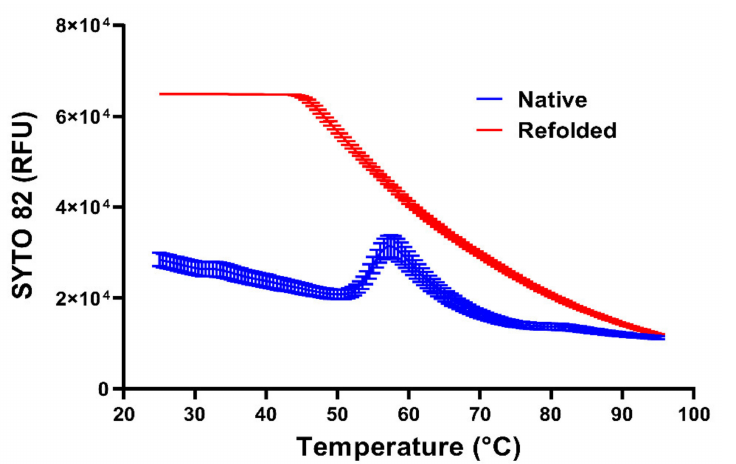
Figure 3. Temperature dependence of the accessibility of RV-A2 RNA for the intercalating dye SYTO 82. Purified RV-A2 in 100 mM potassium phosphate buffer (pH 7.4) was incubated with proteinase K for 12 h at 4 ◦ C, as in Figure 2a. Samples were either kept at 4 ◦ C (native—blue) or kept for 10 min at 90 ◦ C followed by slow cooling (refolded—red) and mixed with SYTO 82 in 100 mM potassium phosphate buffer. Three aliquots of each experimental condition were disposed into the wells of a thin-walled PCR plate, the temperature was ramped from 25–95 ◦ C at 1.5 ◦ C/min, and the SYTO 82 fluorescence signal was